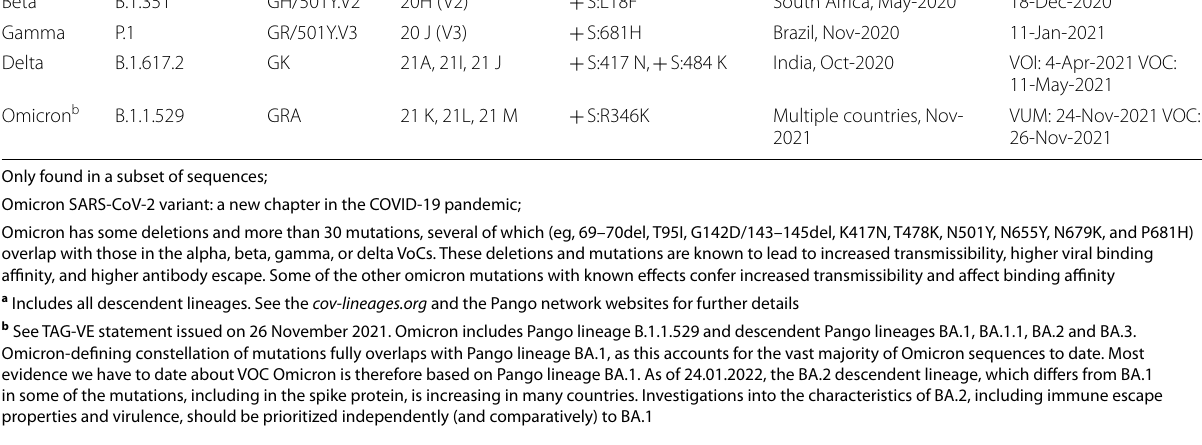
Table 1 Presently labelled variants of concerns (VOCs)